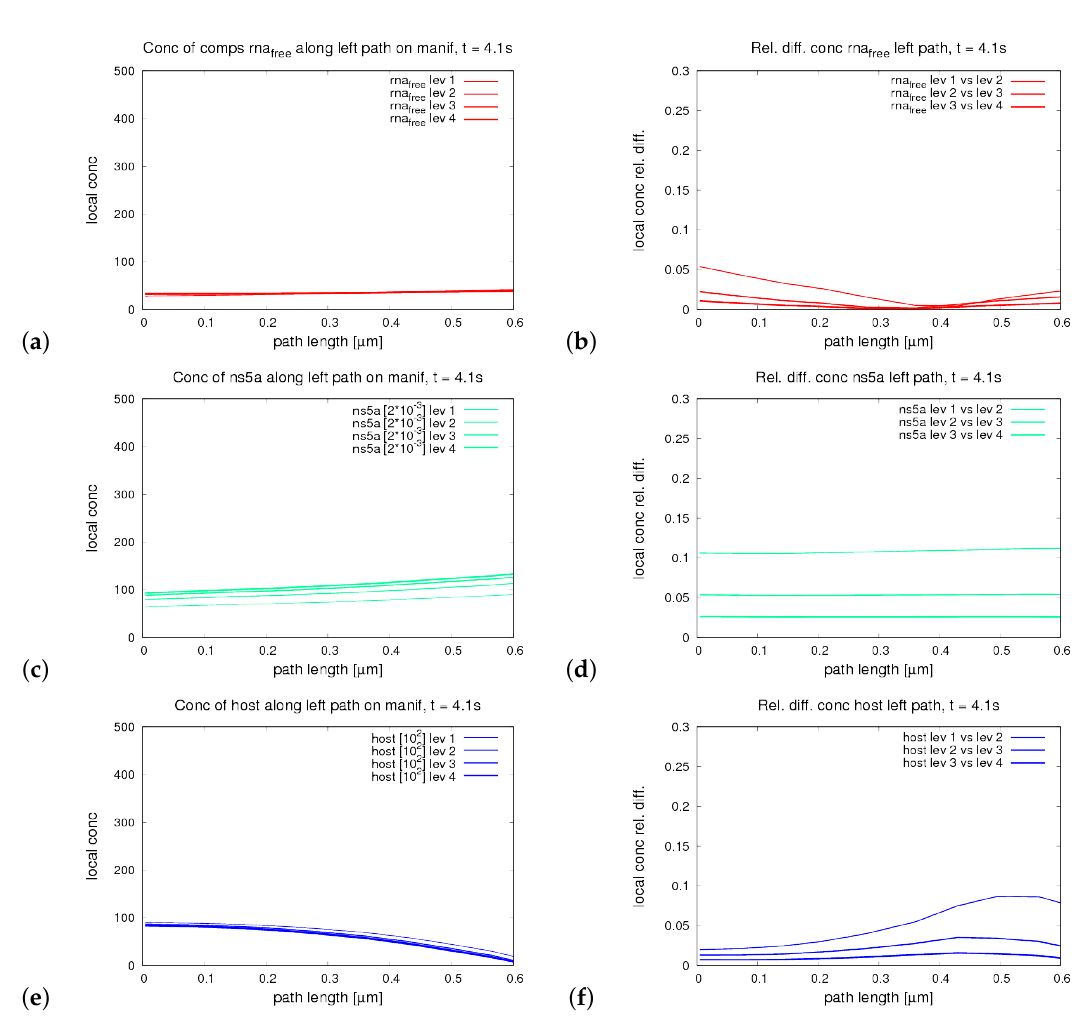
Figure A7. Variation of spatial refinement level for the 1D profiles of the concentrations around a web region. Left sub path. ( a ) Free RNA absolute values, ( b ) free RNA relative differences, ( c ) NS5a absolute values, ( d ) NS5a relative differences, ( e ) host factor absolute values, ( f ) host factor relative differences.